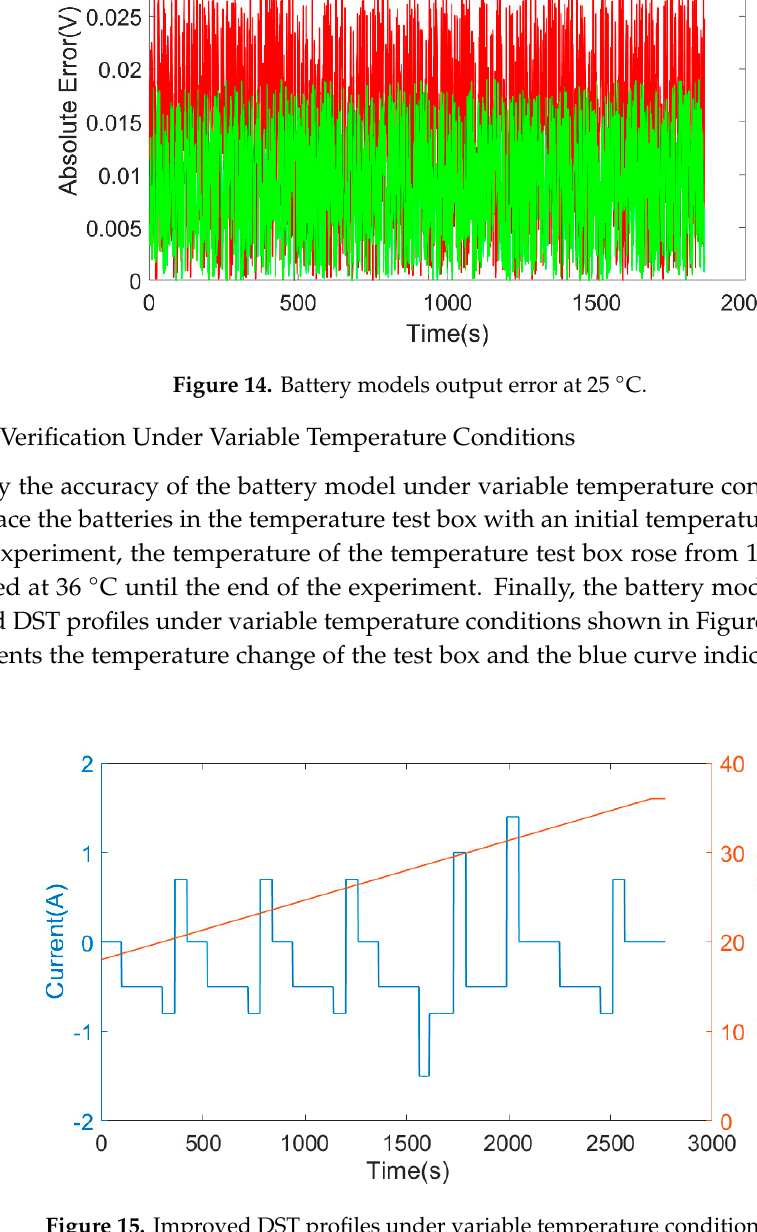
Figure 13. Battery models output and measured voltage at 25 °C .